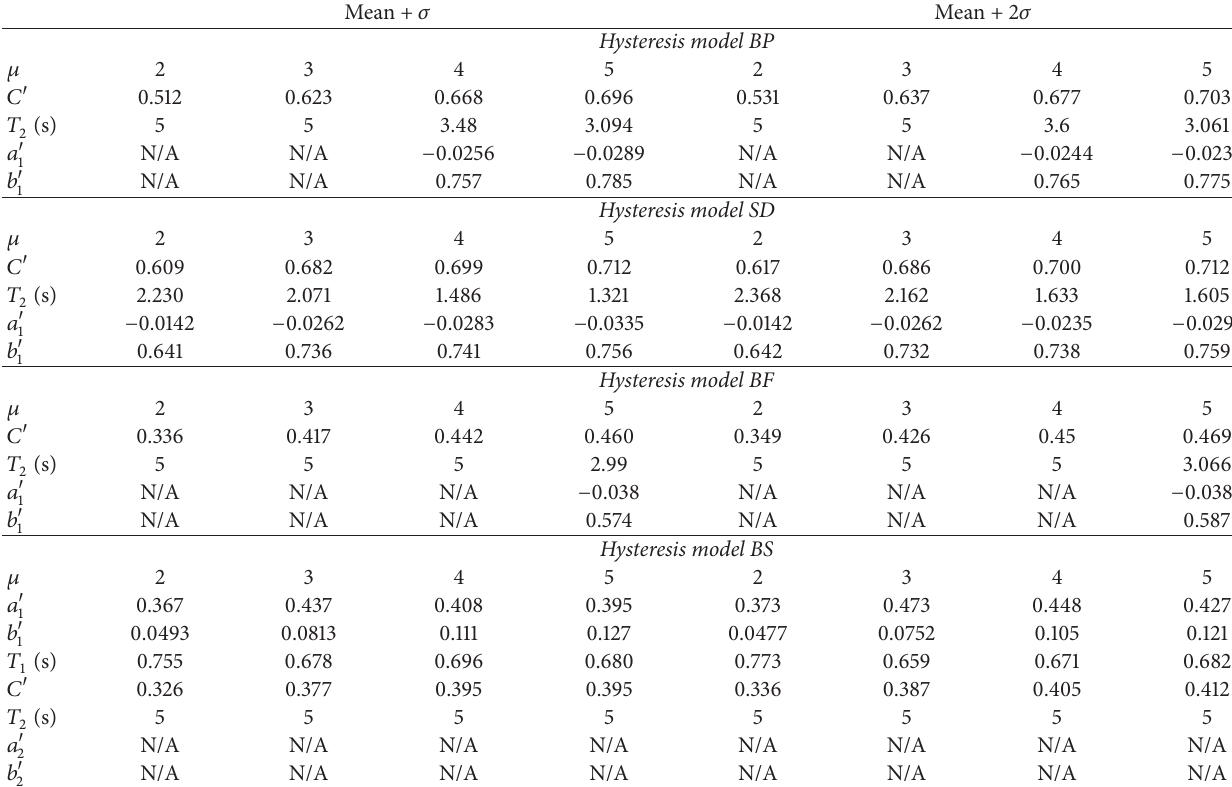
Table 14: HE/IE spectral shape parameters for site class D.